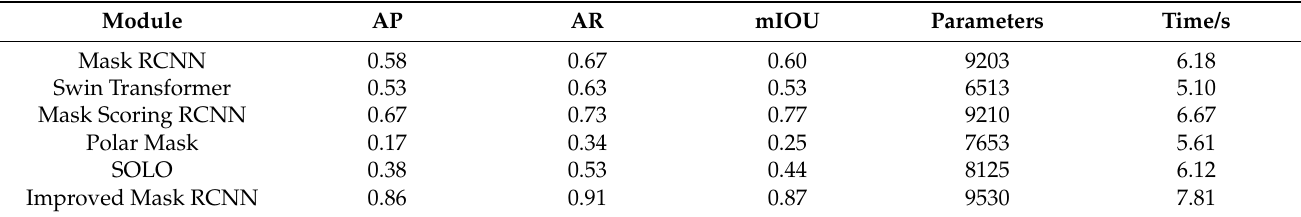
Table 4. Comparison of six segmentation methods in